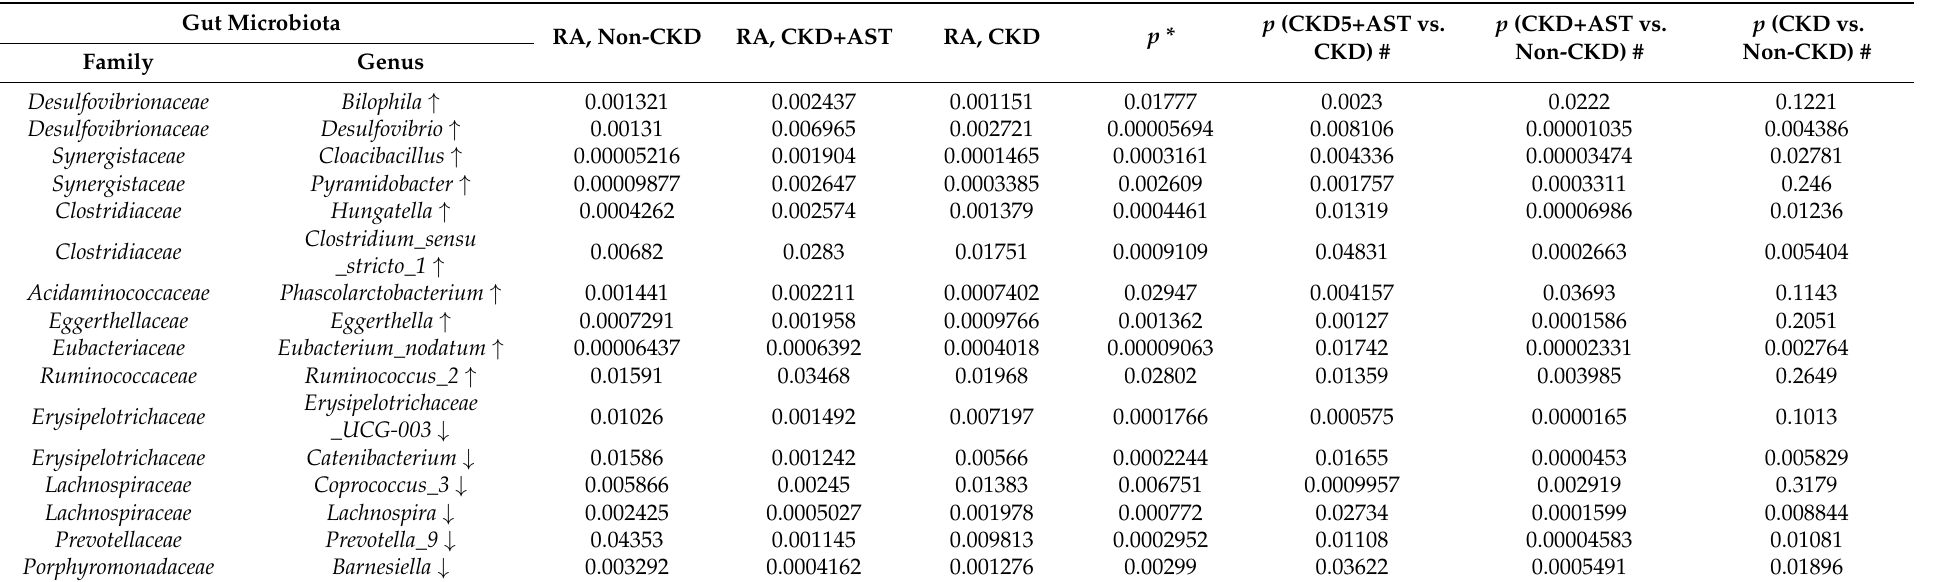
Table 2. Change of intestinal microbial genera associated with AST-120